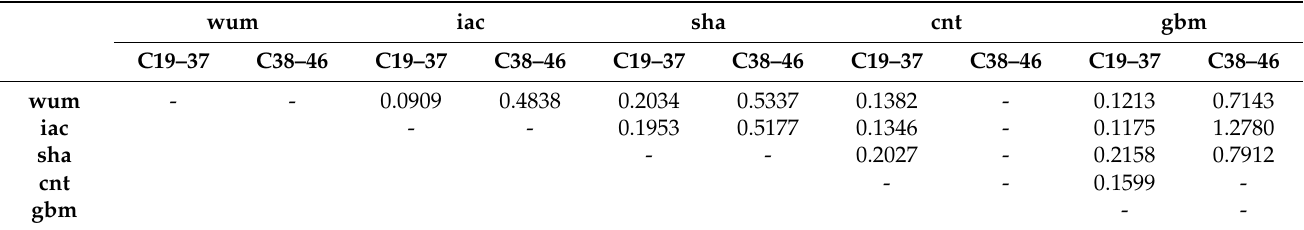
Figure 2. Orbit comparisons of precise BDS-3 products of MGEX ACs with respect to gbm. Table 3. 3D RMS values from comparisons of precise BDS-3 orbit products among MGEX ACs (units: